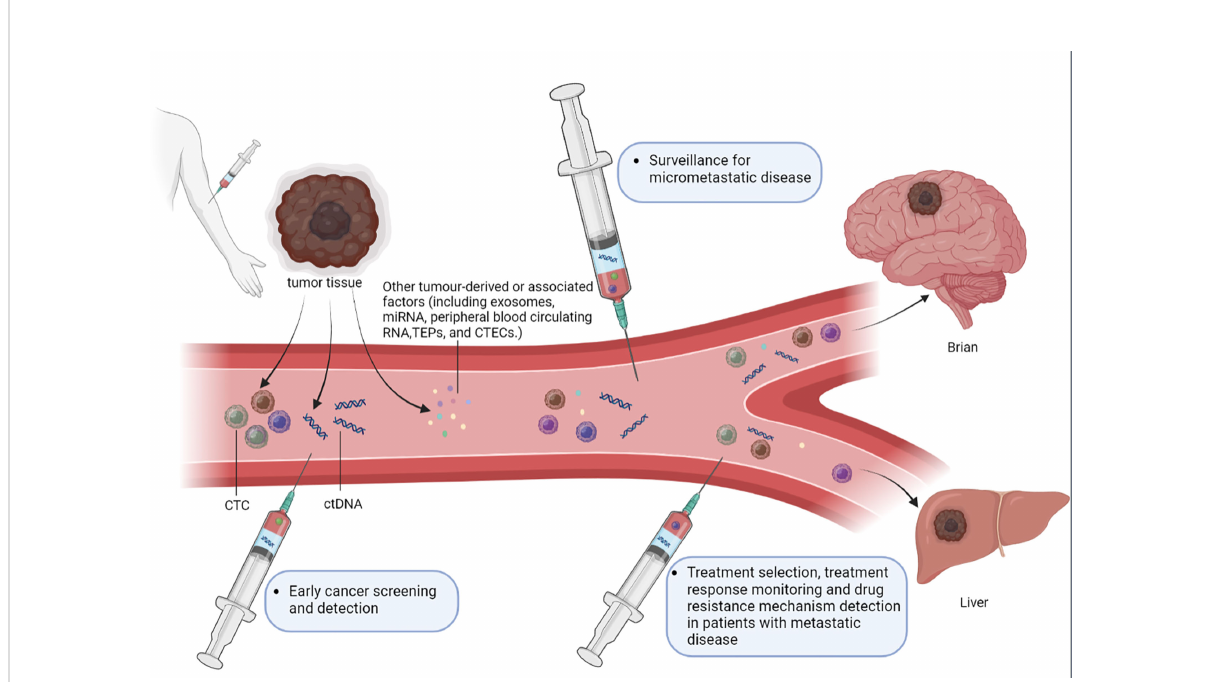
FIGURE 1 The roleofliquid biopsy in MRD detection. Liquid biopsy typically detects circulating tumor cells (CTCs), circulating tumor DNA (ctDNA), exosomes, microRNAs (miRNA), peripheral bloodcirculating RNA, tumor-educated bloodplatelets (TEPs)and circulating tumor vascular endothelial cells (CTECs). Liquid biopsy assaysof these tumor-derived factors can serve several purposes in the MRD detection. (1) Early cancer screening and detection, liquid biopsy approaches could also be used tofurtherinvestigate abnormalities detected onimaging examinations. (2) Surveillancefor micrometastatic disease following curative-intent treatment ofa primarytumor, in order to evaluate the risk of disease recurrence and enabletimely management of recurrent disease. (3) Guiding the selectionof the most appropriate treatment, monitoring treatment responsesand detectingthe resistance mechanisms in patientswith overtmetastatic disease throughdynamic characterization of changes in tumor burden and disease